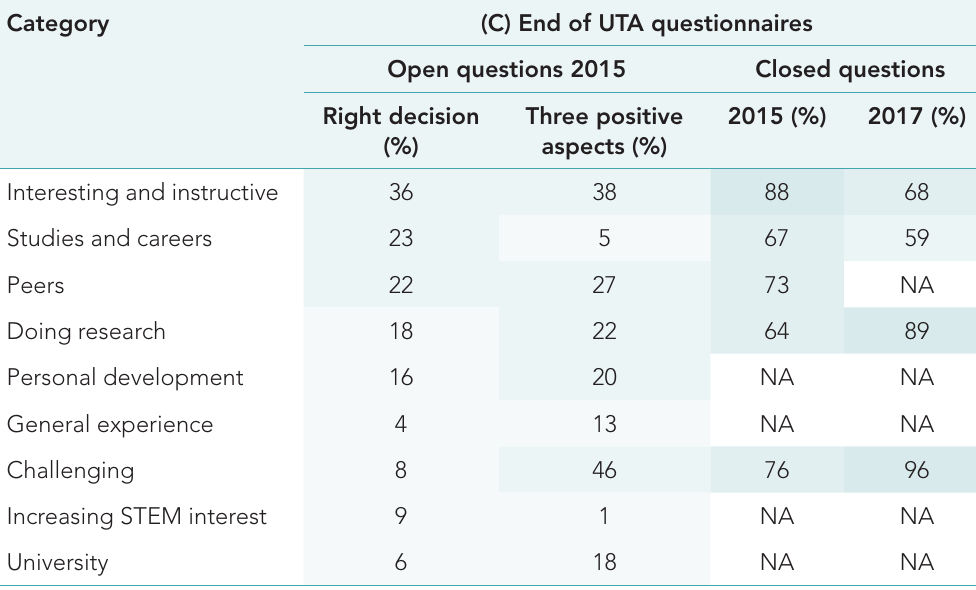
Table 4b: Overview of students’ experiences stated in responses to questionnaires at the end of the